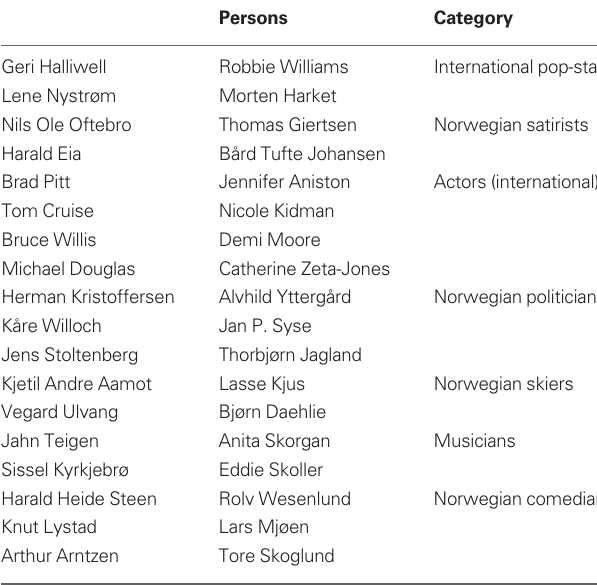
Table A3 | The associated pairs of stimuli used in experiment 1 along with the common category.